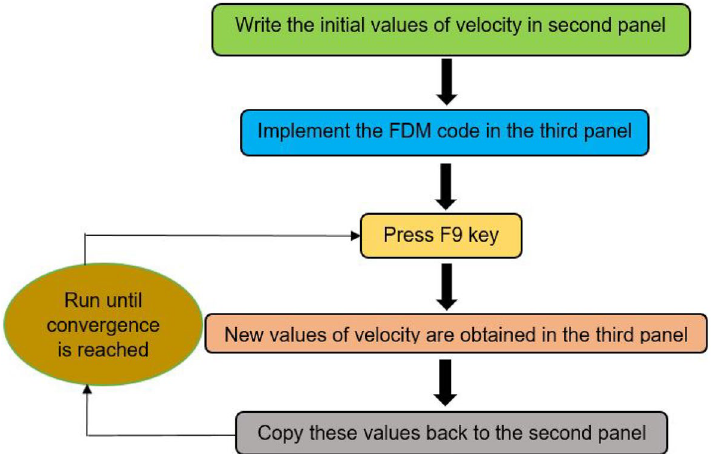
Figure 3. Schematic diagram describing the implementation procedure of the numerical scheme in Microsoft